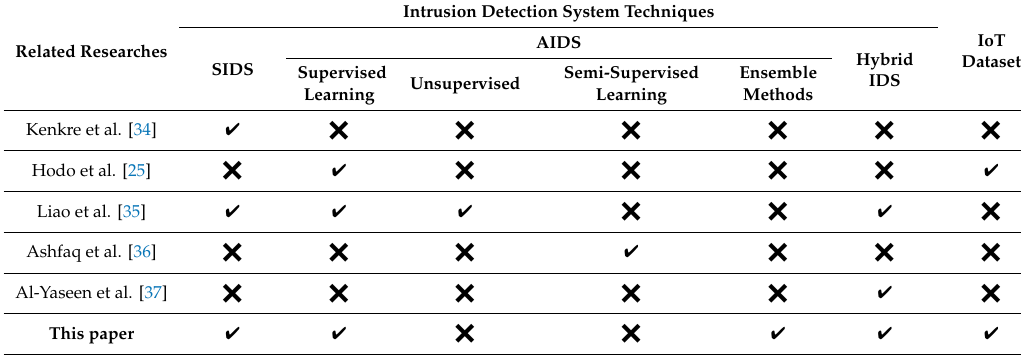
detection for unknown attacks. Table 3 shows the IDS techniques and datasets covered by this paper and previous research papers. Table 3. Comparison of this research and similar researches: ( ✔ : Topic is covered, ✖ the topic is not Table 3. Comparison of this research and similar researches: ( ✔ : Topic is covered, ✖ the topic is not Table 3. Comparison of this research and similar researches: ( ✔ : Topic is covered, ✖ the topic is not Table 3. Comparison of this research and similar researches: ( ✔ : Topic is covered, ✖ the topic is not Table 3. Comparison of this research and similar researches: ( ✔ : Topic is covered, ✖ the topic is not Table 3. Comparison of this research and similar researches: ( ✔ : Topic is covered, ✖ the topic is not covered). covered). covered). covered). covered). covered). Table 3. Comparison of this research and similar researches: ( ✔ : Topic is covered, ✖ the topic is not Table 3. Comparison of this research and similar researches: ( ✔ : Topic is covered, ✖ the topic is not Table 3. Comparison of this research and similar researches: ( ✔ : Topic is covered, ✖ the topic is not Table 3. Comparison of this research and similar researches: ( ✔ : Topic is covered, ✖ the topic is not Table 3. Comparison of this research and similar researches: ( ✔ : Topic is covered, ✖ the topic is not covered). covered). covered). covered). covered). Table 3. Comparison of this research and similar researches: ( ✔ : Topic is covered, ✖ the topic is not Table 3. Comparison of this research and similar researches: ( ✔ : Topic is covered, ✖ the topic is not Table 3. Comparison of this research and similar researches: ( ✔ : Topic is covered, ✖ the topic is not covered). covered). covered). Table 3. Comparison of this research and similar researches: ( ✔ : Topic is covered, ✖ the topic is not Table 3. Comparison of this research and similar researches: ( ✔ : Topic is covered, ✖ the topic is not Table 3. Comparison of this research and similar researches: ( ✔ : Topic is covered, ✖ the topic is not Table 3. Comparison of this research and similar researches: ( ✔ : Topic is covered, ✖ the topic is not Table 3. Comparison of this research and similar researches: ( ✔ : Topic is covered, ✖ the topic is not Table 3. Comparison of this research and similar researches: ( ✔ : Topic is covered, ✖ the topic is not covered). covered). covered). covered). covered). Table 3. Comparison of this research and similar researches: ( ✔ : Topic is covered, ✖ the topic is not Table 3. Comparison of this research and similar researches: ( ✔ : Topic is covered, ✖ the topic is not Table 3. Comparison of this research and similar researches: ( ✔ : Topic is covered, ✖ the topic is not Table 3. Comparison of this research and similar researches: ( ✔ : Topic is covered, ✖ the topic is not Table 3. Comparison of this research and similar researches: ( ✔ : Topic is covered, ✖ the topic is not Table 3. Comparison of this research and similar researches: ( ✔ : Topic is covered, ✖ the topic is not covered). covered). covered). covered). covered). Table 3. Comparison of this research and similar researches: ( ✔ : Topic is covered, ✖ the topic is not Table 3. Comparison of this research and similar researches: ( ✔ : Topic is covered, ✖ the topic is not covered). Table 3. Comparison of this research and similar researches: ( (cid:52) : Topic is covered,